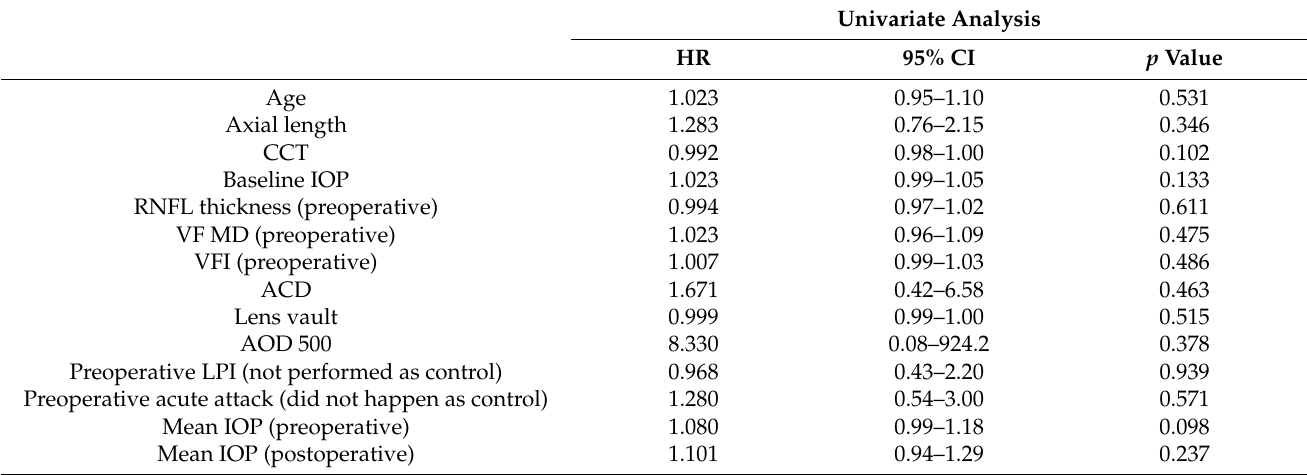
Table 5. Cox proportional hazards model to determine clinical variables associated with structure progression in primary angle closure